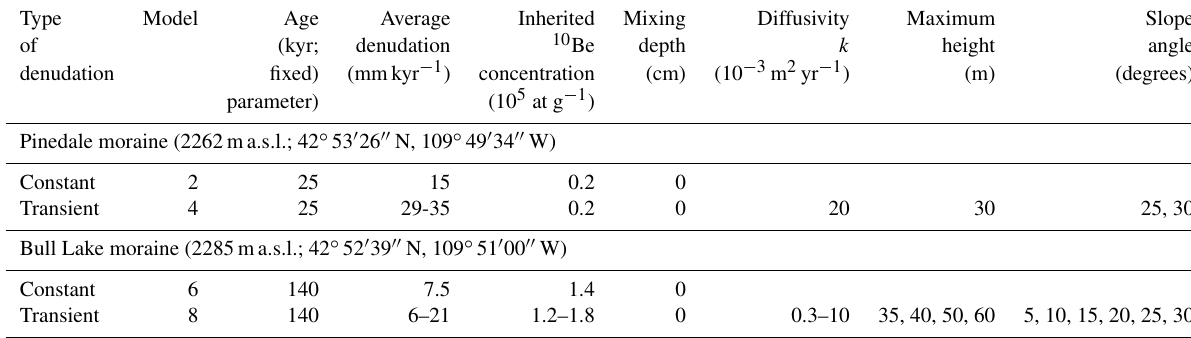
Table 1. Recalculated chi square solutions for different denudation rate simulations of Schaller et al. (2009a) ∗ . Type Model Age Average Inherited Mixing Diffusivity Maximum Slope of (kyr; denudation 10 Be depth k height angle denudation fixed) (mmkyr − 1 ) concentration (cm) (m)